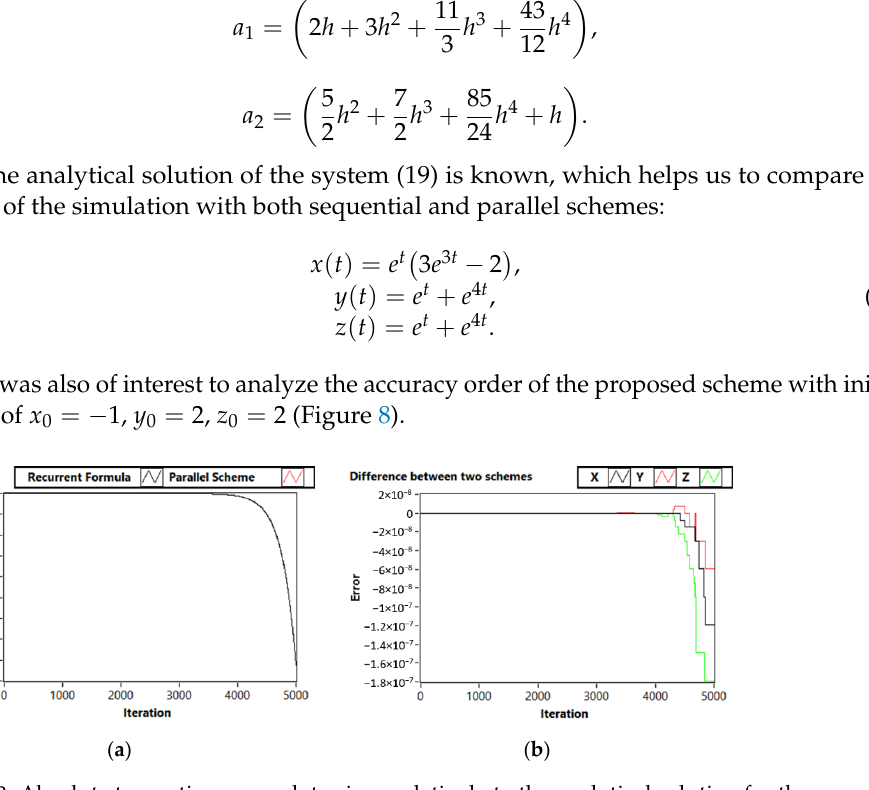
Figure 8. Absolute truncation error plots given relatively to the analytical solution for the recurrent Runge–Kutta method and proposed parallel scheme ( a ). Difference between the truncation errors for parallel and serial solvers ( b ). Simulation time 5 s, step size value 0.001 s.